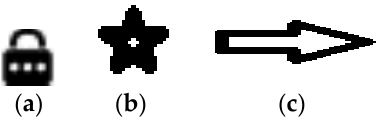
Figure 9. Watermarks used ( a ) 16 × 16 bits ( b ) 32 × 32 bits ( c ) 64 × 64bits.